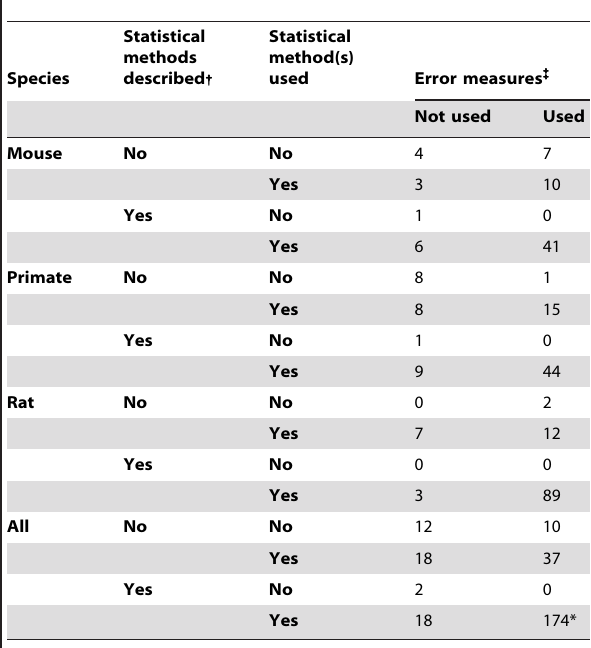
{ Statistical methods described in materials and methods section of paper. { Standard error of the mean, confidence interval, standard deviation or other error measurement. * 70% (174/247); 91% (247/271) of all included studies used statistical methods to analyse the data; 17% (46/267) of the studies, that presented numerical data, did not present a measure of variation (e.g. standard deviation) or uncertainty (e.g. standard error of the mean [SEM] or confidence interval